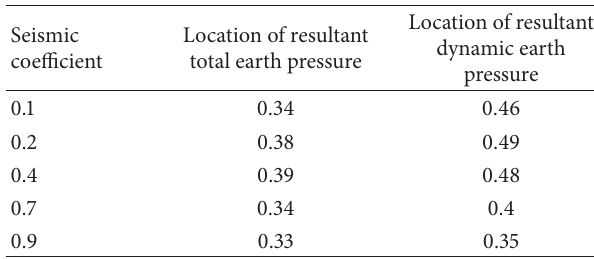
Table 1: Location of resultant earth pressure of road shoulder retaining wall on rock foundation ( ℎ / 𝐻 ).